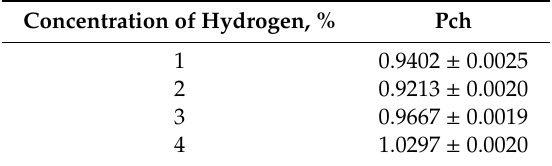
Table 3. The percentage change P ch calculated for 150 ◦ C, Sample 2, carrier gas: synthetic air.